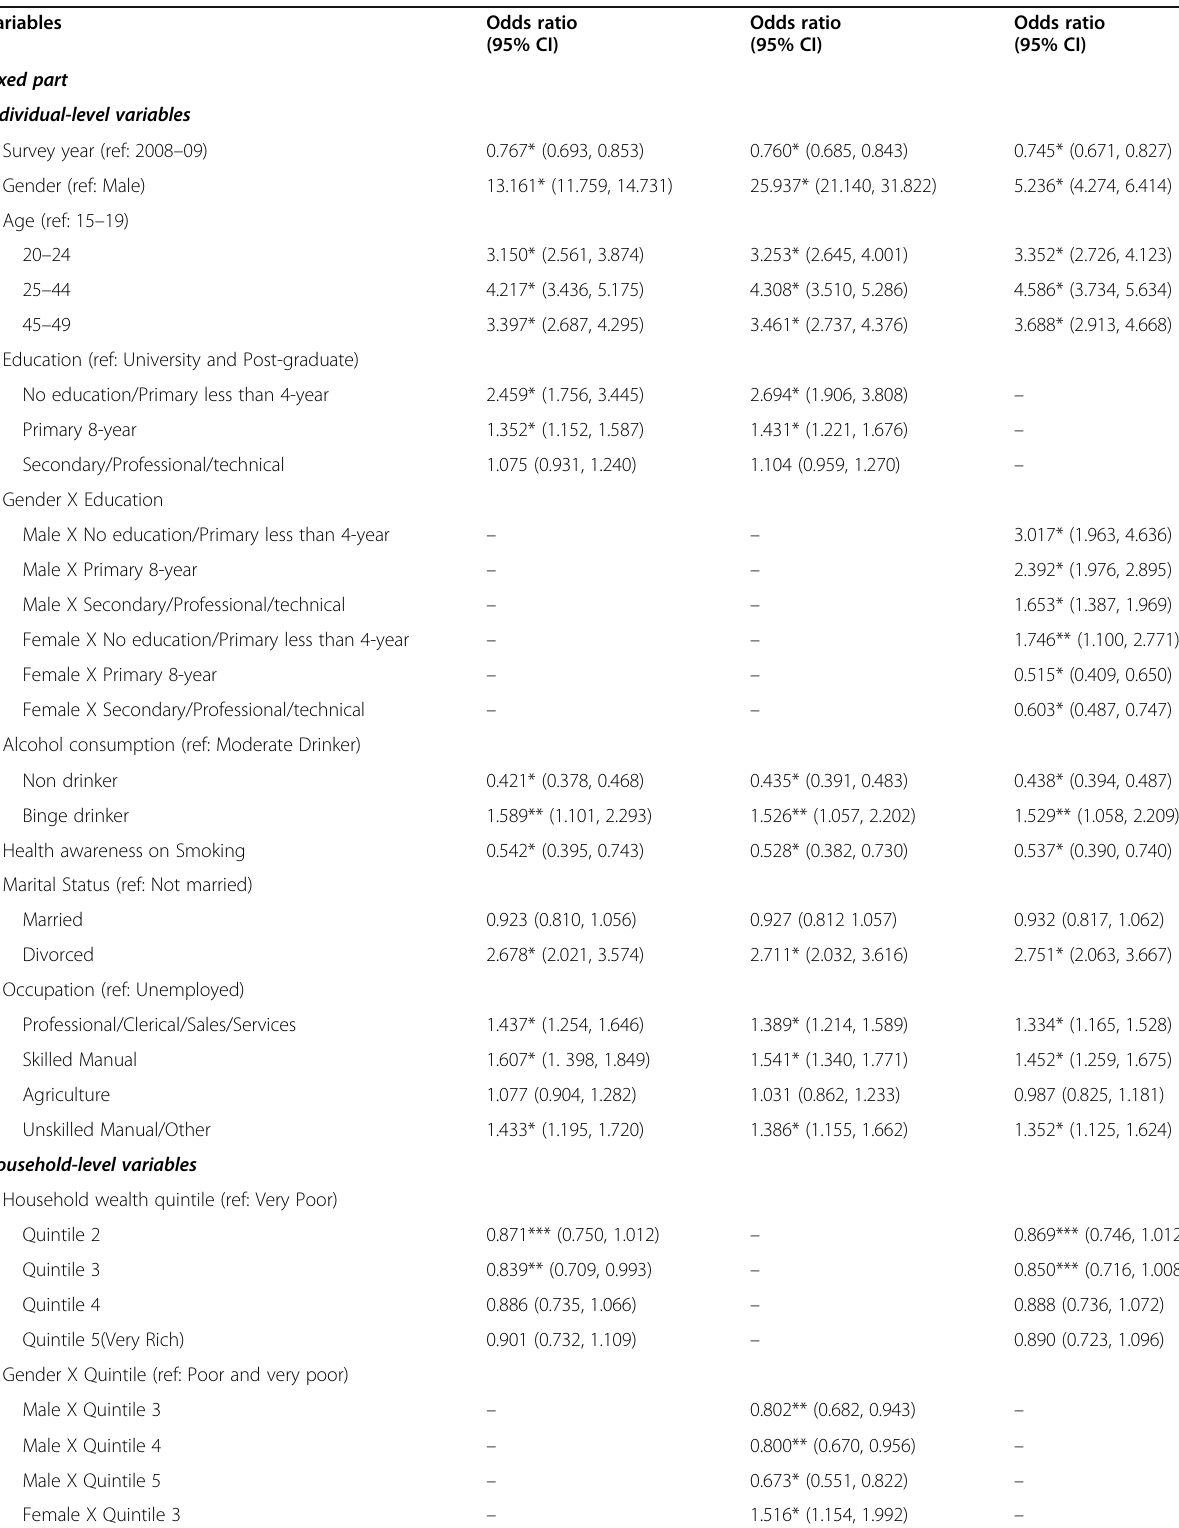
Table 3 Multilevel Logistic Regression results for Smoking